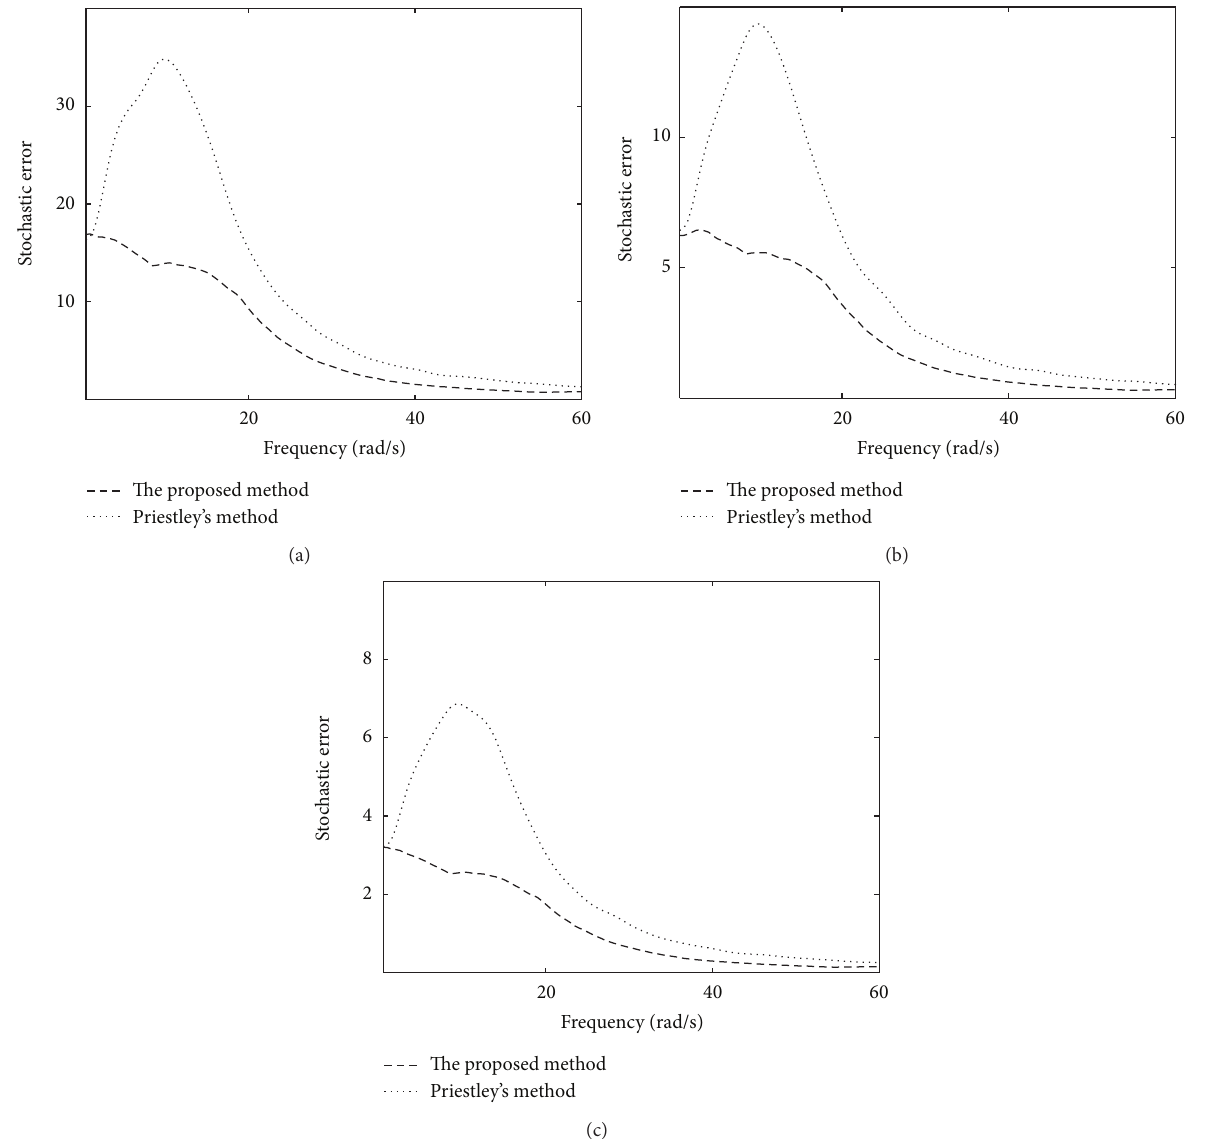
Figure 8: Comparison between the stochastic errors of the proposed method 𝑆 12 (𝜔,𝑡) and Priestley’s method 𝑆𝑃 12 (𝜔,𝑡) : (a) at time instant t = 2 s; (b) at time instant t = 4s; (c) at time instant t =